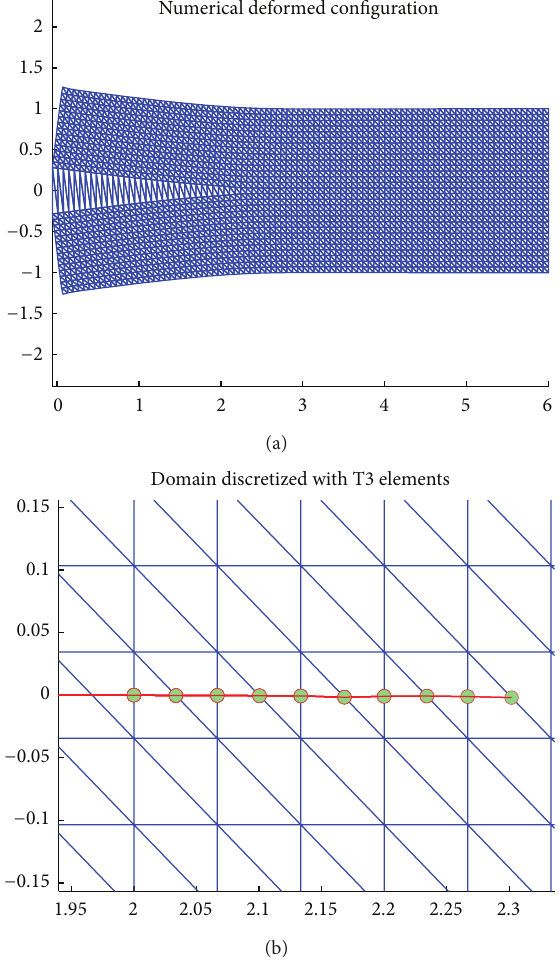
Figure 25: (a) Deformed shape of the double cantilever beam (structured mesh) and (b) crack path simulated by ES-Phantom node method (structured mesh) after ten-step growing in which the filled circles are the new crack tip after each